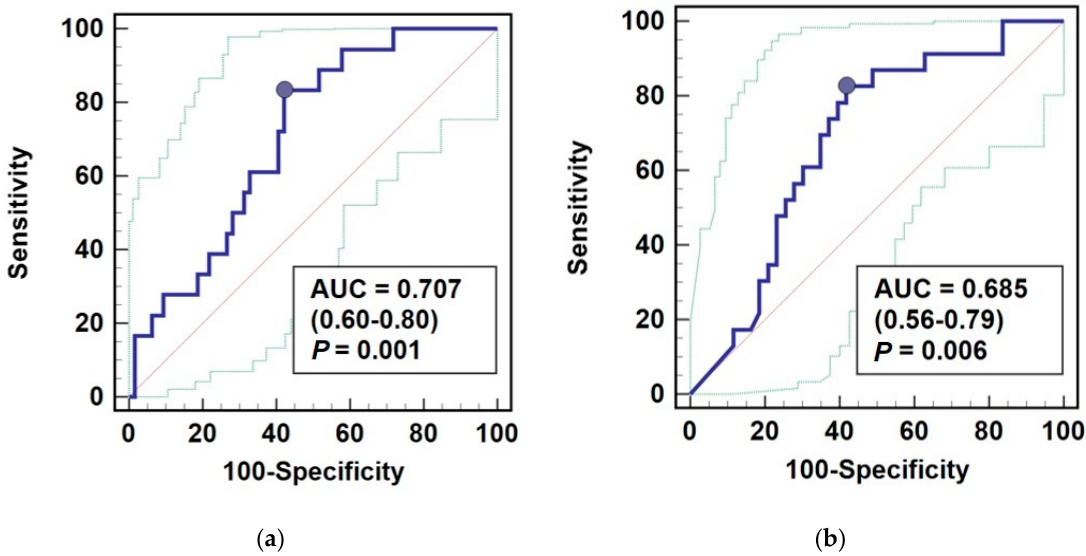
Figure 7. AGE10 as biomarker of: ( a ) microangiopathy; ( b ) stage ≥ 3 chronic kidney disease. Data presented as receiver operating characteristics (ROC) curves (solid blue line) with 95% confidence interval (dotted green lines). The performance of a chance marker devoid of discriminating power (AUC = 0.5) is represented by diagonal red line and optimal cut-off value is indicated as closed blue circle. AUC, area under ROC curve.